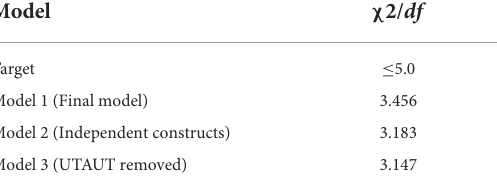
TABLE 3 Overall of validity and reliability for